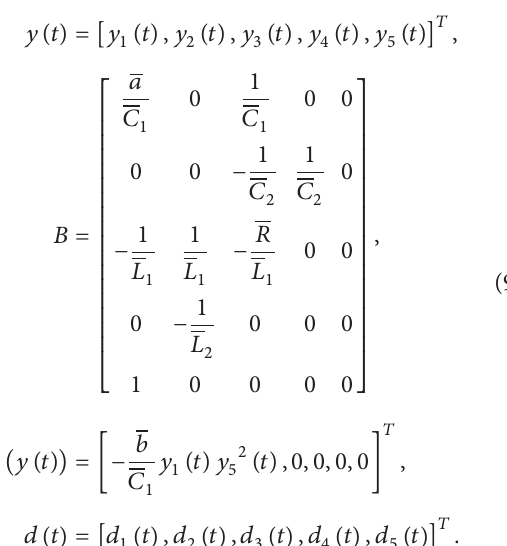
Figure 1: Memristor-based five-order chaotic circuit. where